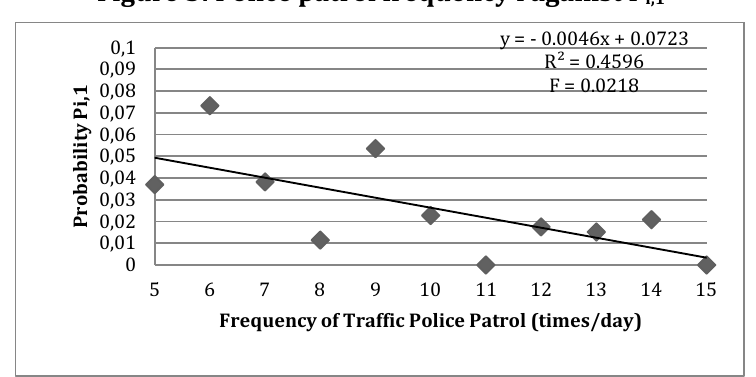
Figure 3: Police patrol frequency i against P